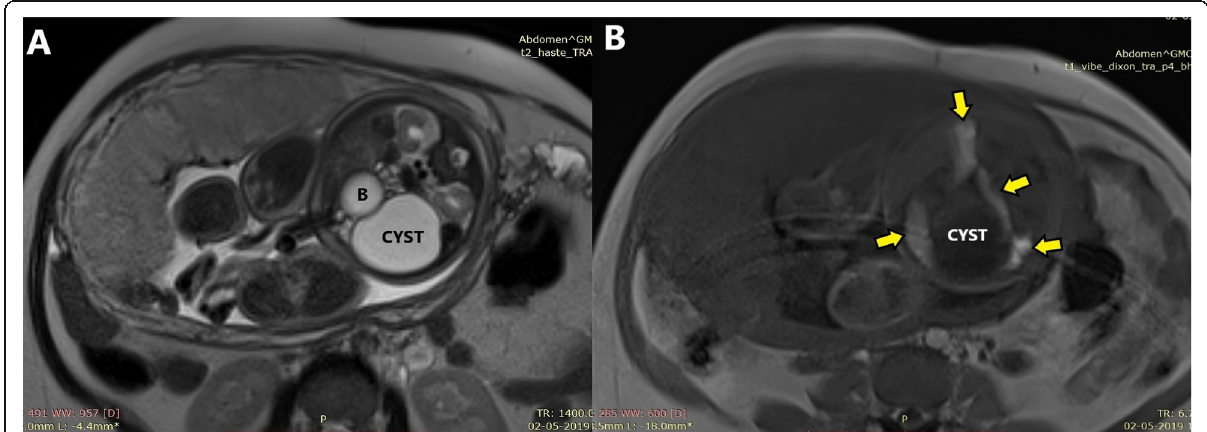
Fig. 8 Ovarian cyst: maternal age: 24 years; period of gestation: 35 weeks 2 days: T2 HASTE axial ( a ) a simple ovarian cyst in the left abdominopelvic region (labeled “ cyst ” ) adjacent to the bladder (labeled as b ) with no features of complications. Axial T1 VIBE image ( b ) clarifies the inter-relationship of cyst with adjacent T1 hyperintense meconium-filled colon